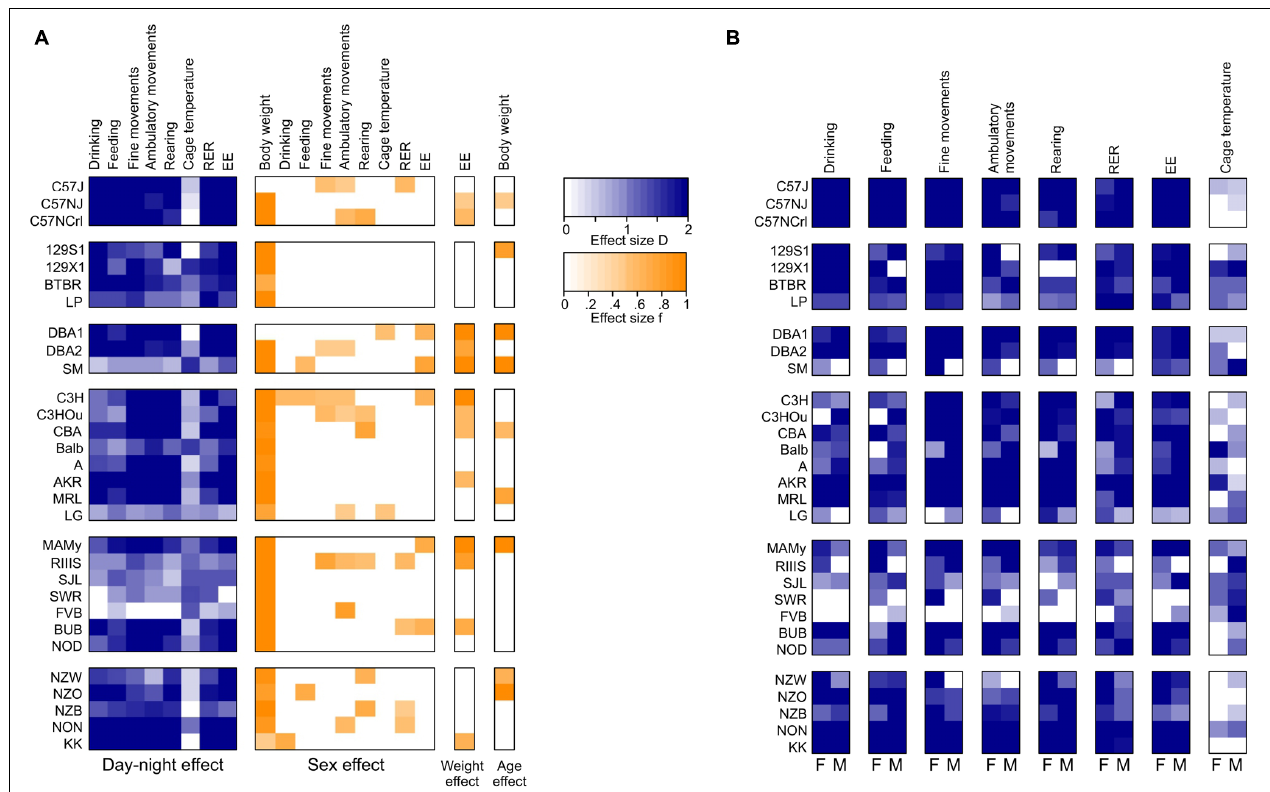
FIGURE 11 | Heat map summarizing for all traits and strains, sex effects and day-night differences for pooled and separate sexes. (A) Day–night-differences are given as Cohen’s D , sex effects, weight effect on EE and age effect on body weight are given as f and calculated from partial Eta squared η 2 p ; (B) day–night- differences as Cohen’s D reported for separate sexes. White boxes represent insignificant